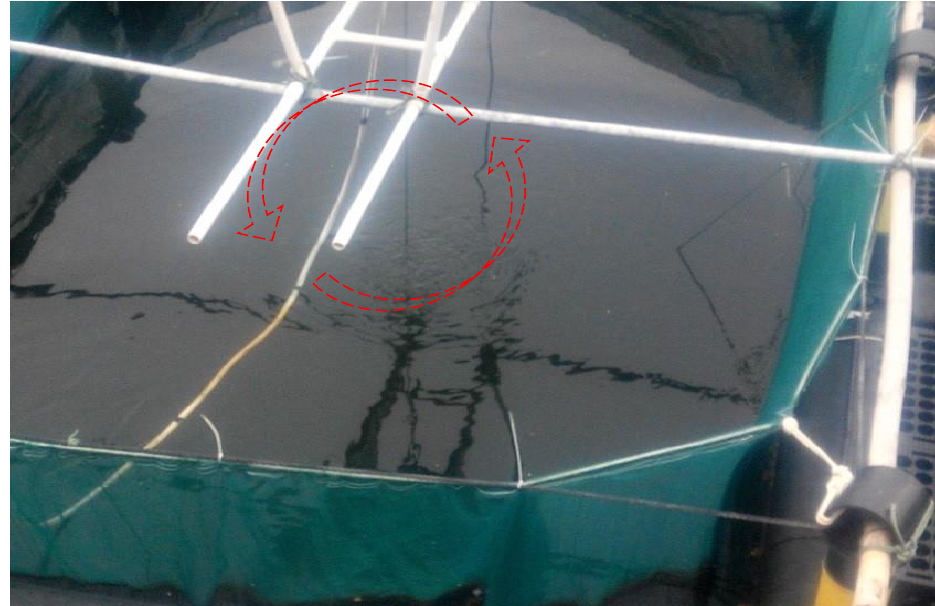
Figure 11. The behavioral responses of juvenile Pagrus major when the sound was played.